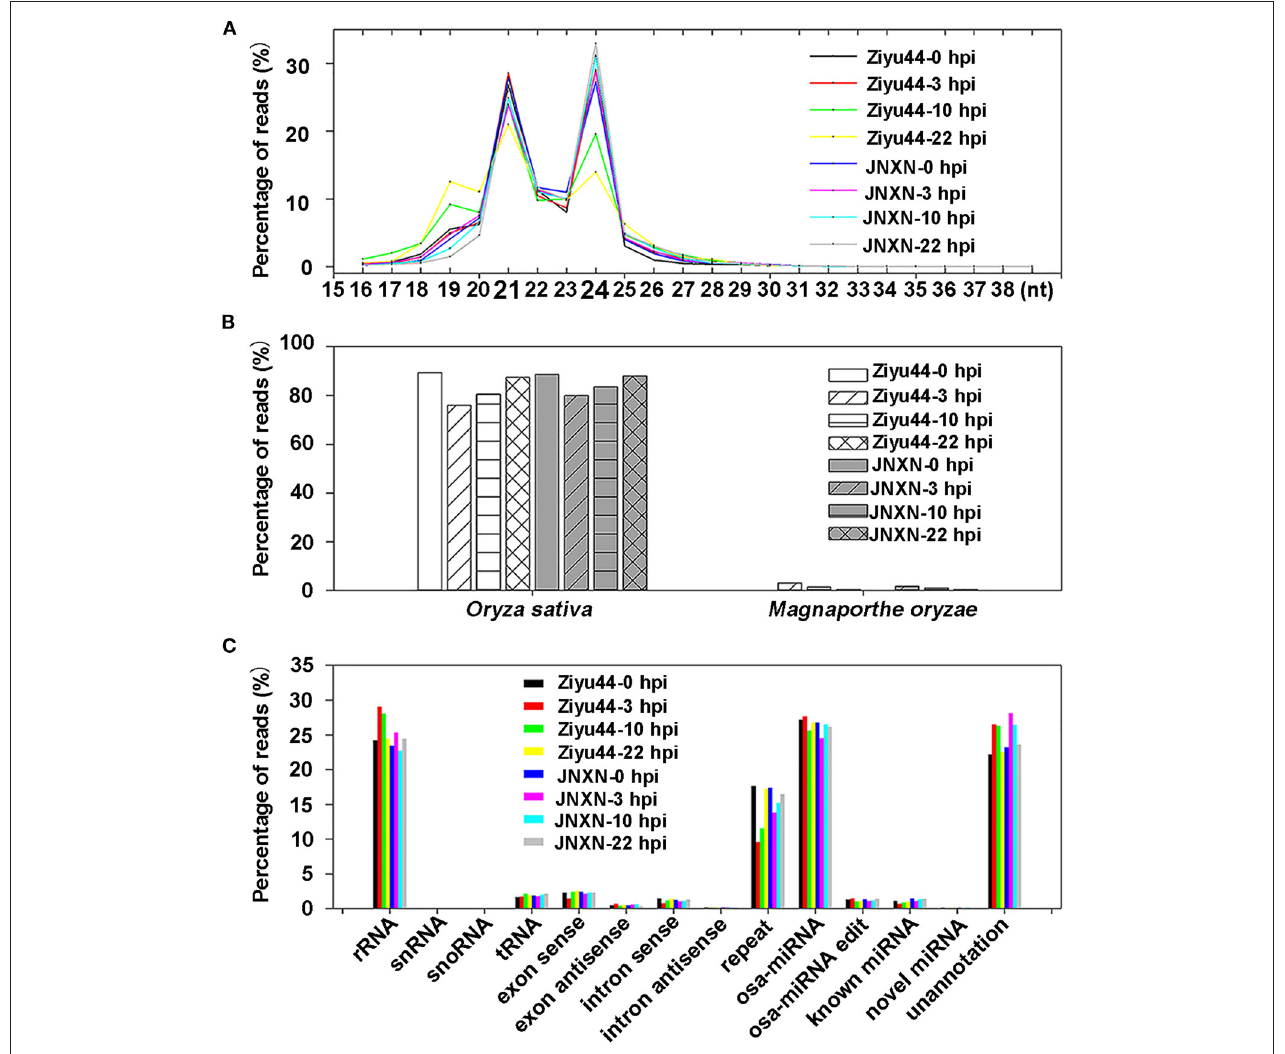
FIGURE 1 | Analysis of small RNA sequencing data. (A) Size distribution of small RNAs reads. (B) The bar charts show the percentage of small RNA reads matched to the rice and Magnaporthe oryzae genomes. (C) The bar charts show the percentage of small RNA reads matched to the different rice RNAs commentary in the GeneBank/Rfam database, reference genome, and miRBase database. Ribosomal RNA (rRNA), small nuclear RNA (snRNA), small nucleolar RNA (snoRNA), and transfer ribonucleic acid (tRNA); exon sense/exon antisense, intron sense/intron antisense might be fragments from mRNA degradation; repeat sequences include DNA transposon, long terminal repeat, long interspersed nuclear element, short interspersed nuclear element. osa-miRNA is rice miRNA included in miRBase. osa-miRNA edit means the base editing status of osa-miRNAs in our samples. Known microRNA (miRNA) refers to the miRNA of other species. Novel miRNA is miRNA predicted by software. Unannotation is unannotated clean